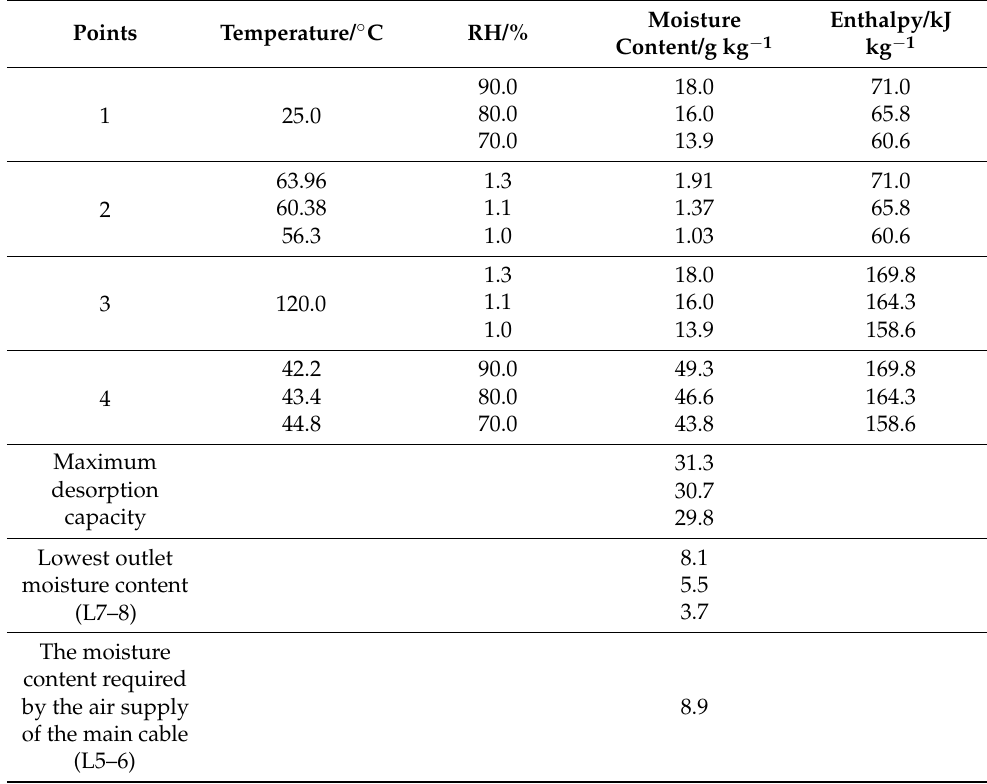
Table A3. Calculation result at inlet air temperature of 25 ◦